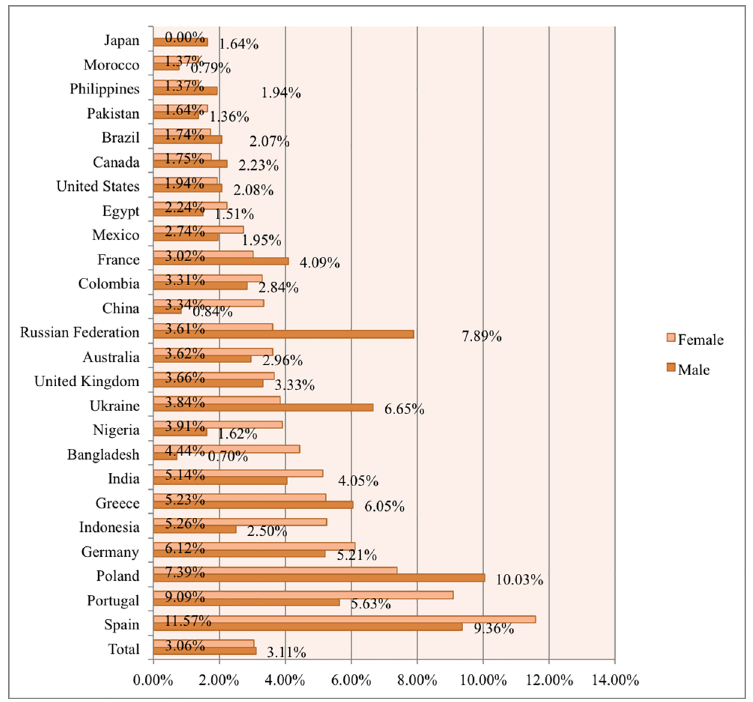
Fig 4. Percentage of STEM MOOC enrollees in each country who completed one or more STEM MOOC, by gender.